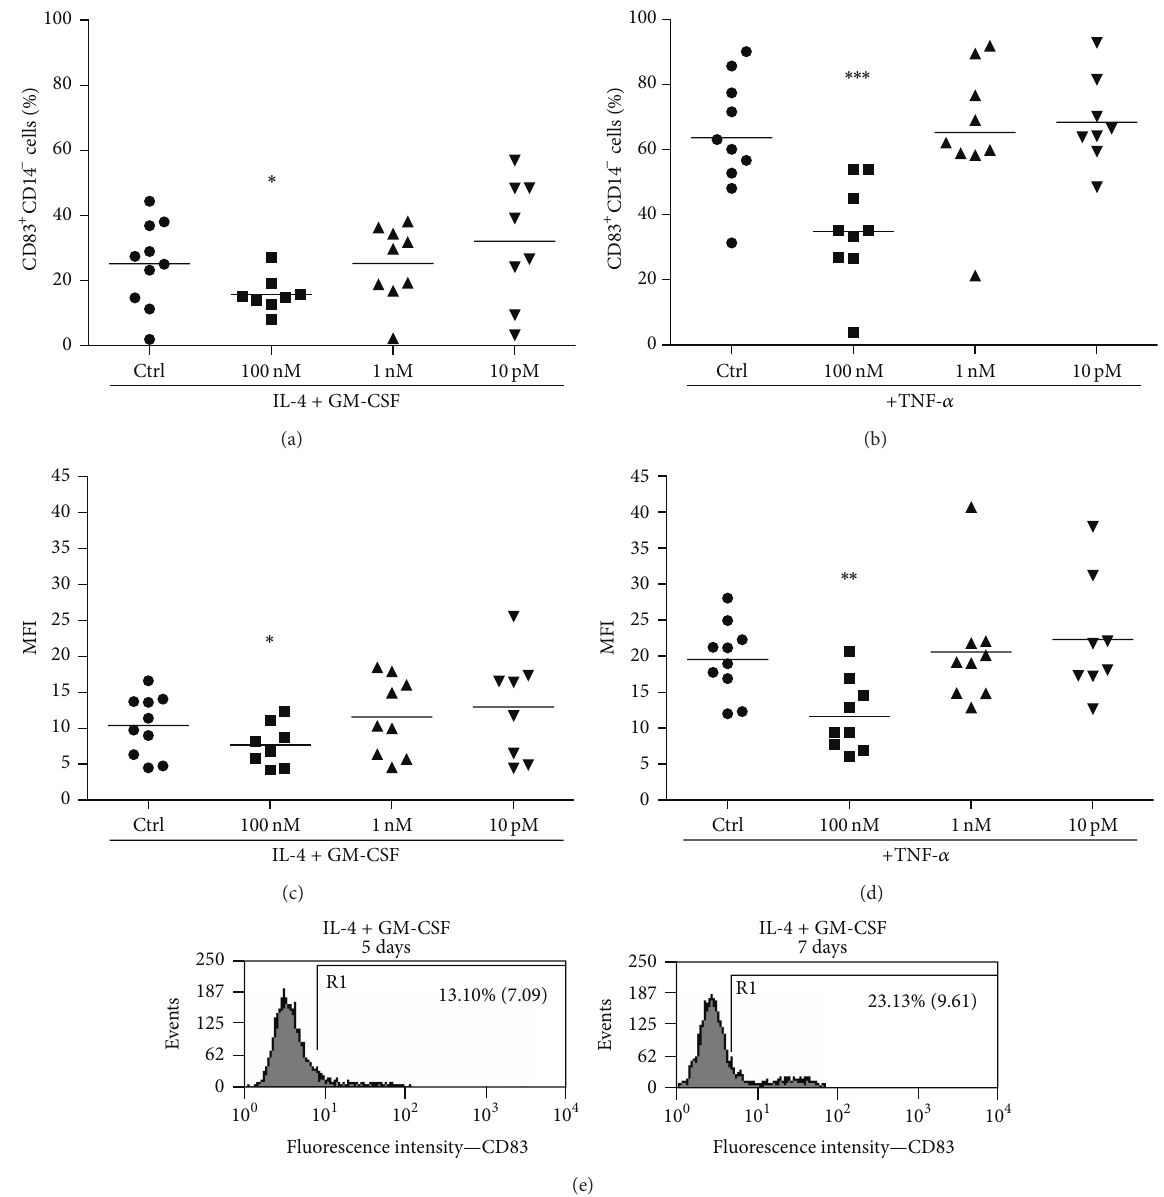
Figure2:OuabaineffectonCD83expressionindendriticcellsduringactivation.Afterthedifferentiationperiod(5days),cellswereincubated for further 48h in the presence (b, d) or absence of TNF- 𝛼 (50 ng/mL) (a, c) and in the presence or absence of 100 nM, 1nM, or 10pM Oua. CD83 expression was analyzed by flow cytometry. Data are expressed as the percentage of CD14 − CD83 + cells ((a) and (b) panels) or the means of fluorescence intensities (MFI: (c) and (d) panels), and lines denote the means of at least eight independent experiments. (e) Cells were incubated for 5 or 7 days with IL-4 + GM-CSF, and CD83 expression was analyzed. The percentage of positively stained cells (R1) and their means of fluorescence intensities are indicated in the representative histogram. ∗ , ∗∗ , and ∗ ∗ ∗ are significantly different from the control ( ∗ 𝑃 < 0.05 ; ∗∗ 𝑃 < 0.01 ; ∗∗∗ 𝑃 < 0.001 ).